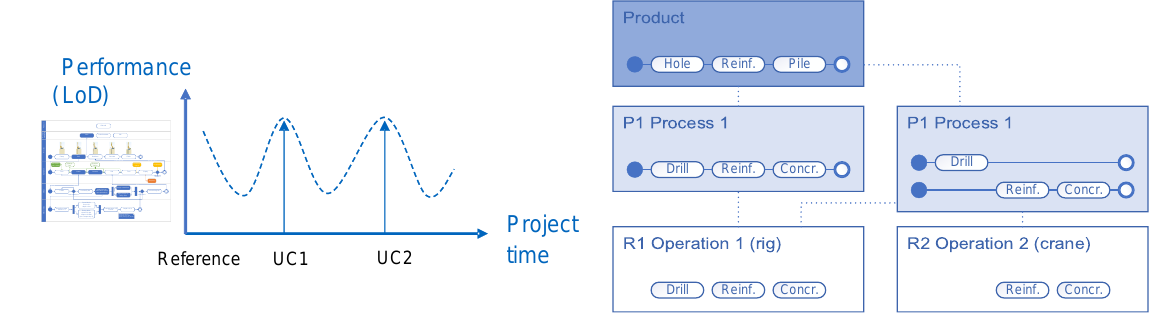
Figure 16. Nübel’s catalog of construction processes (UC: use case; LoD: level of detail).